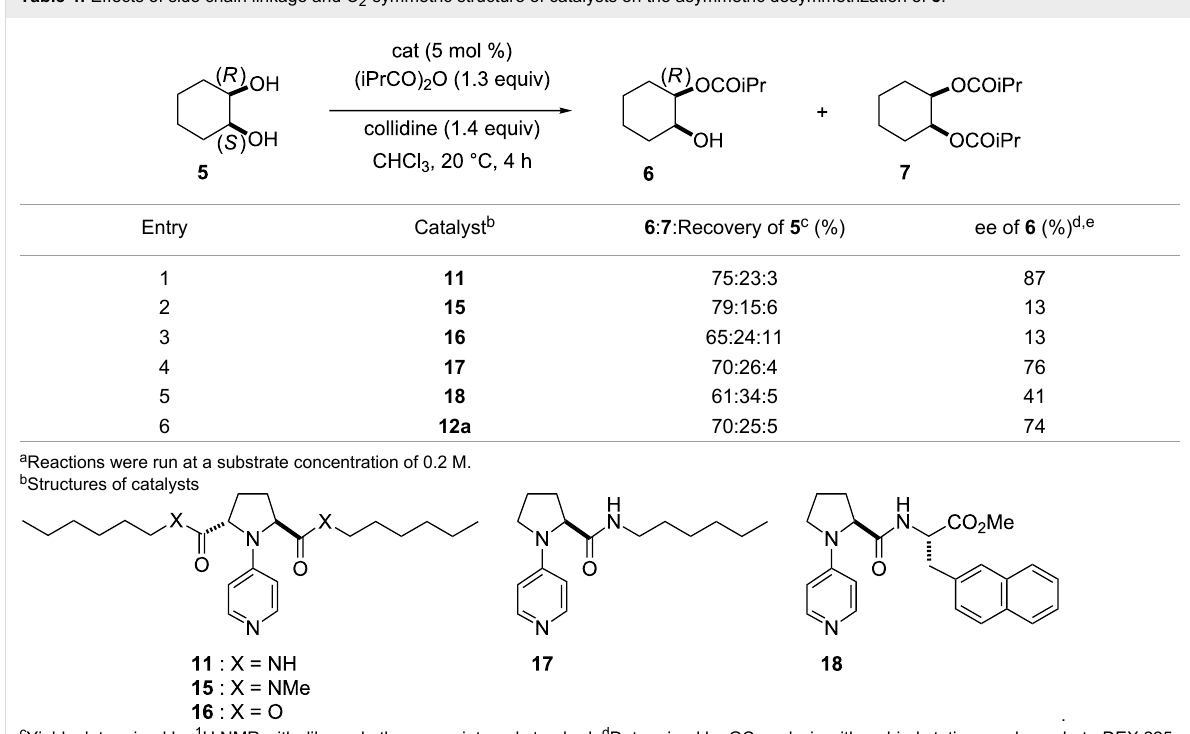
Table 4: Effects of side chain linkage and C 2 -symmetric structure of catalysts on the asymmetric desymmetrization of 5 . a